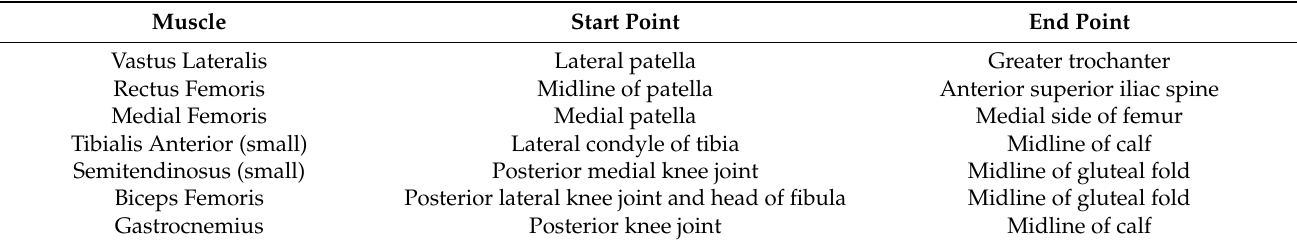
Table 2. The landmarks of seven muscles.